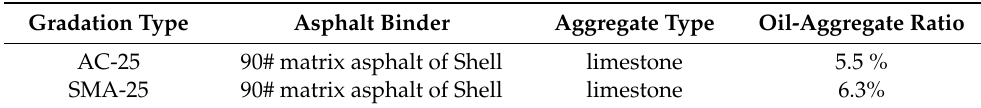
Table 4. Preparation parameter of asphalt mixture.